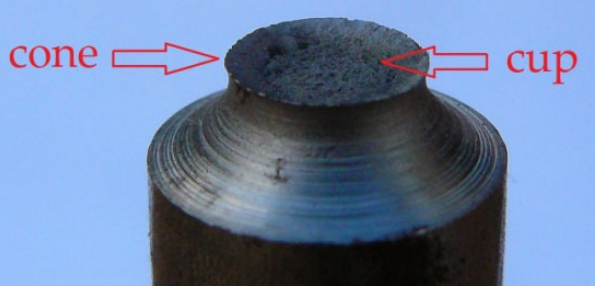
Figure 2. An example of a S355 steel specimen failure due to void development. Characteristic cup–cone shape is clearly visible [authors’ own study]. cup–cone shape is clearly visible [authors’ own